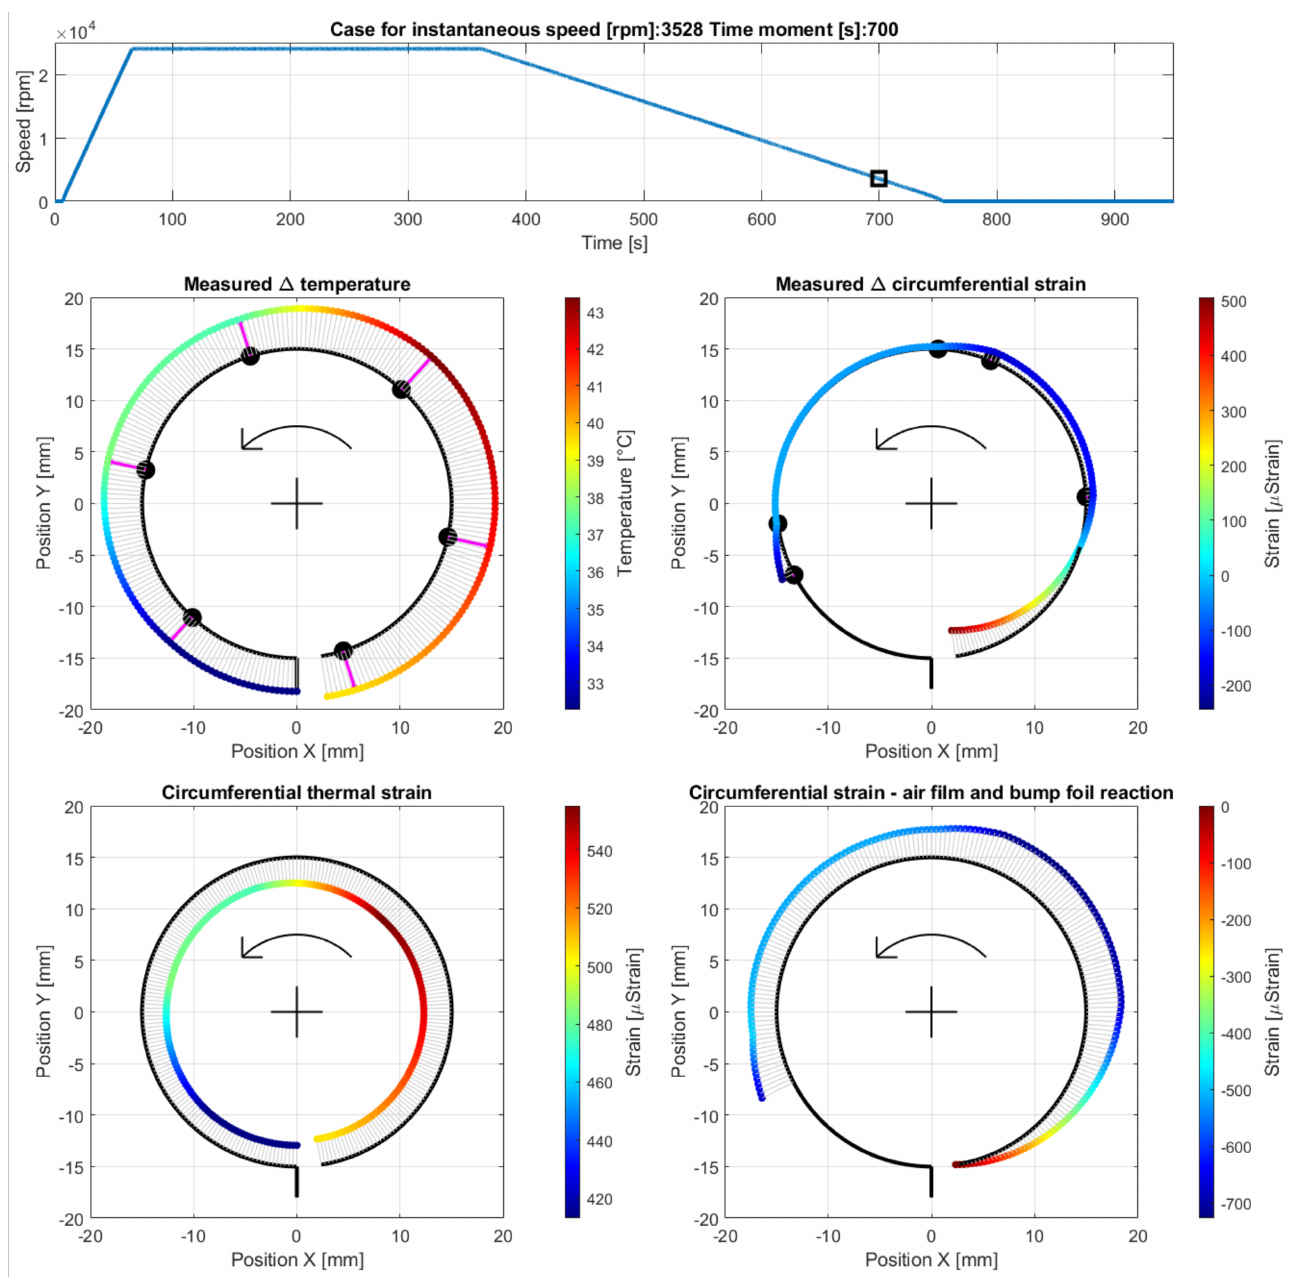
Figure 16. Cross-sectional views for the circumferential distribution of the temperature and strain identified in the top foil at 3528 rpm during the end of the run-out stage of the GFB’s operation after the air film was completely lost. The curves used to visualize the strains are rescaled by the factor 0.5 with respect to the previously shown